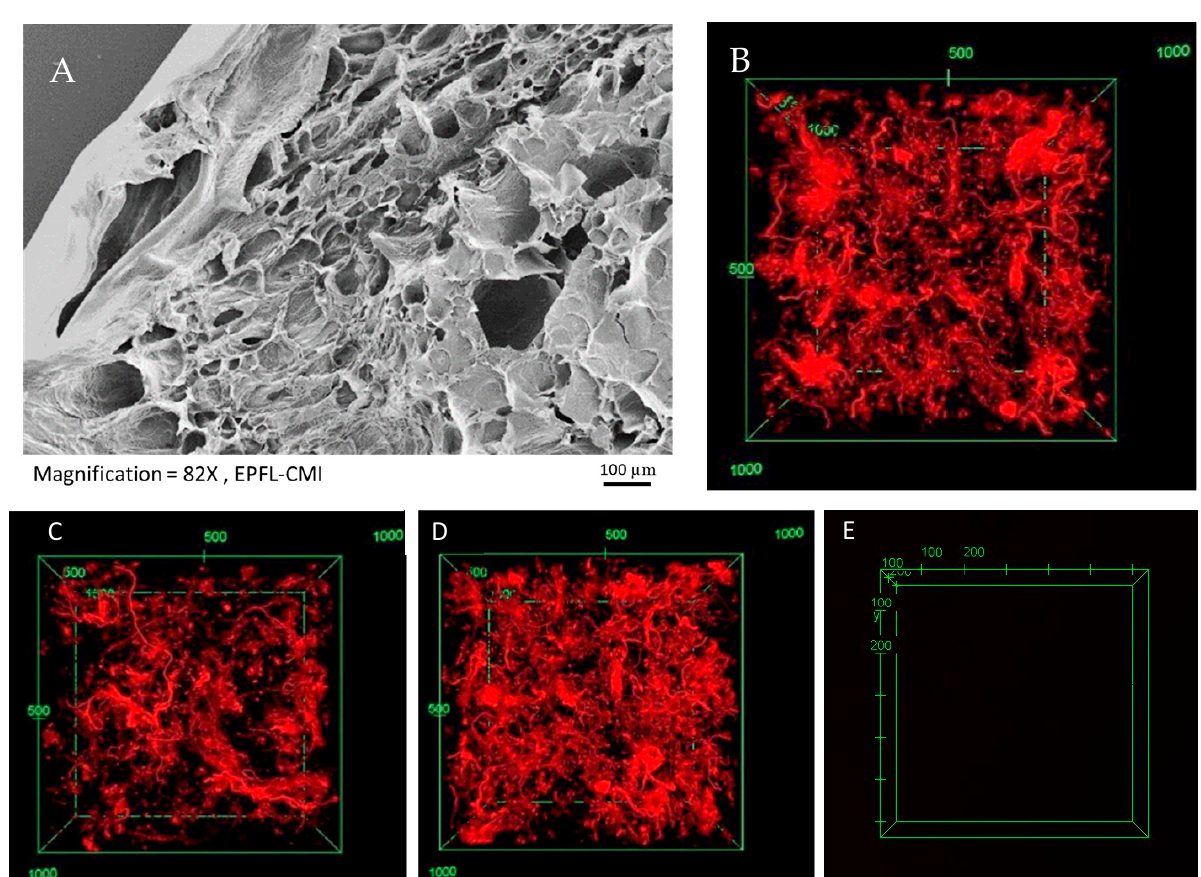
Figure 4. Microstructural analysis of dECM-fibrin gels. ( A ) Scanning electron microscopy image of the dECM-fibrin hydrogel is depicted. ( B – D ) dECM was labeled with rhodamine isothiocyanate before being subjected to gelation with fibrin. Confocal images after ( B ) 1 day, ( C ) 7 days, and ( D ) 14 days are pictured. ( E ) dECM-fibrin hydrogel without rhodamine labelling is shown. The distribution of dECM is locally heterogeneous. No significant loss of dECM occurs during this time. Scale bar: 100 µ m. The hydrogel boxes in ( B – D ) are 1000 µ m by 1000 µ